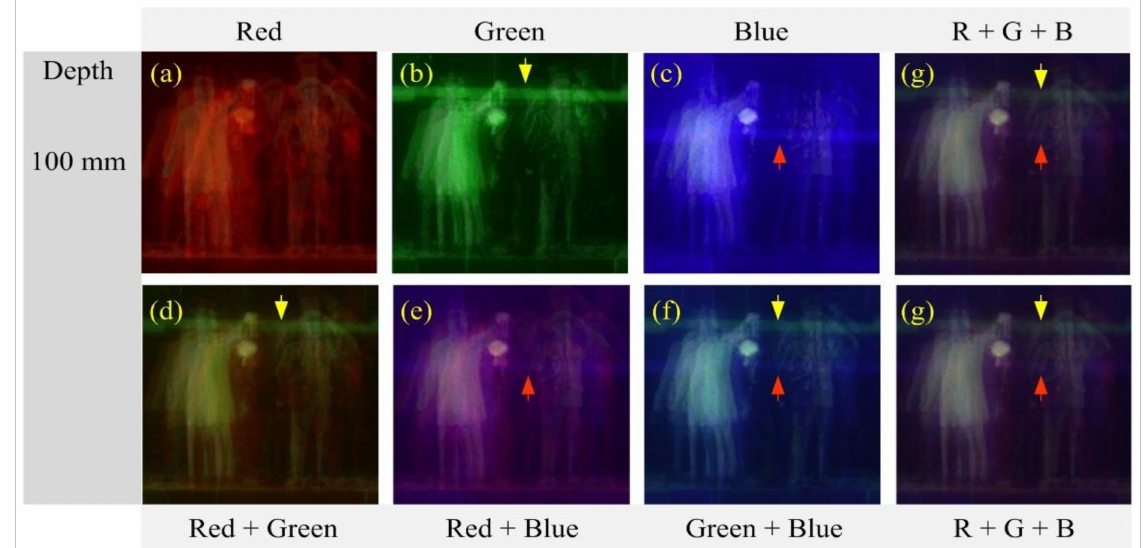
Figure 12. 3-D reconstructed images for the PIAs in Figure 9b. Each image of three columns’ left is reconstructed from a single PIA. Each image of four columns’ right is reconstructed from multiple PIAs. The row indicates the arbitrary depth of each image.